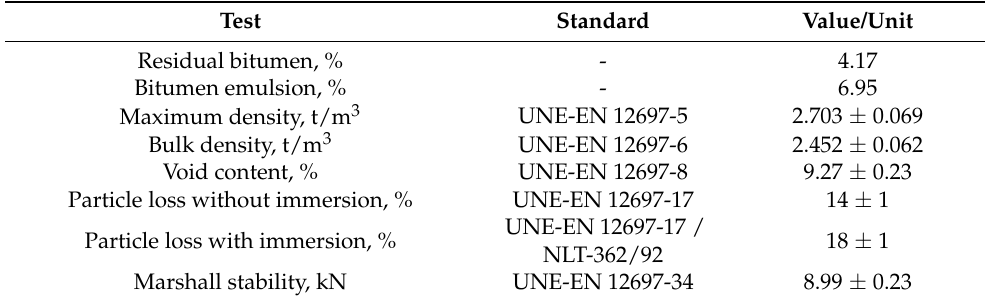
Table 8. Results of the physical and mechanical tests of the test samples conforming with the optimum percentage of bitumen